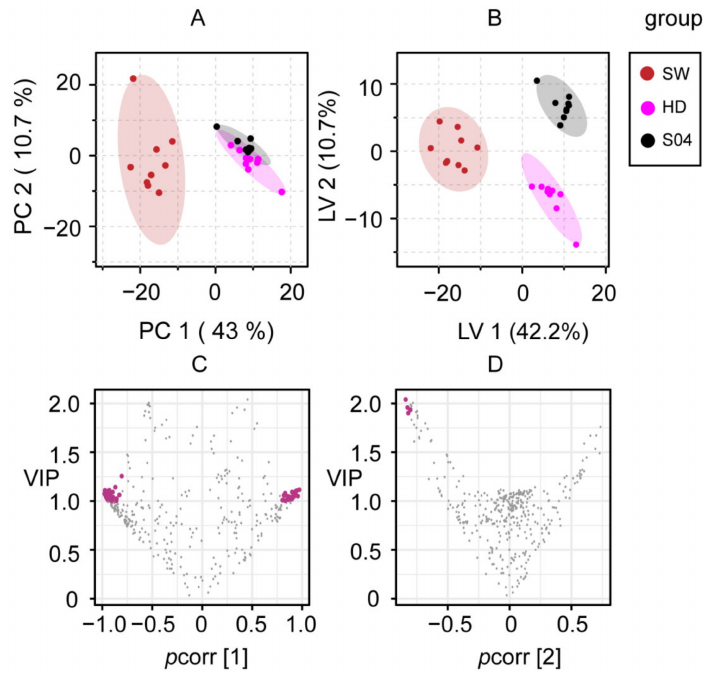
Figure 4. Multivariate analysis of 2D 1 H- 13 C HSQC spectra of SR processed using different methods, sweating (SW, claret), hot-air drying (HD, peach), and steaming for 4 h (S04, black). ( A ) PCA and ( B ) PLS-DA score plots. ( C , D ) Volcano plots of VIP and p (corr) of variables from PLS-DA. Differential variables with VIP > 1.0 and | p (corr)| > 0.8 are highlighted in magenta.